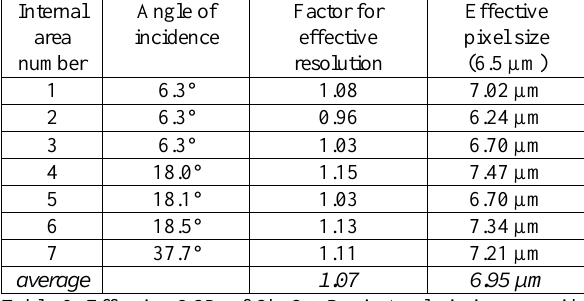
Table 6: Effective GSD of SkySat Basic Analytic images